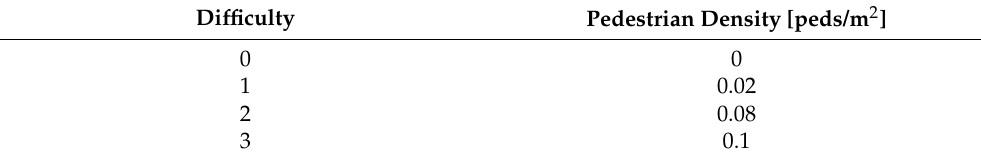
Table 3. Mapping between the difficulty levels and the pedestrian density in the